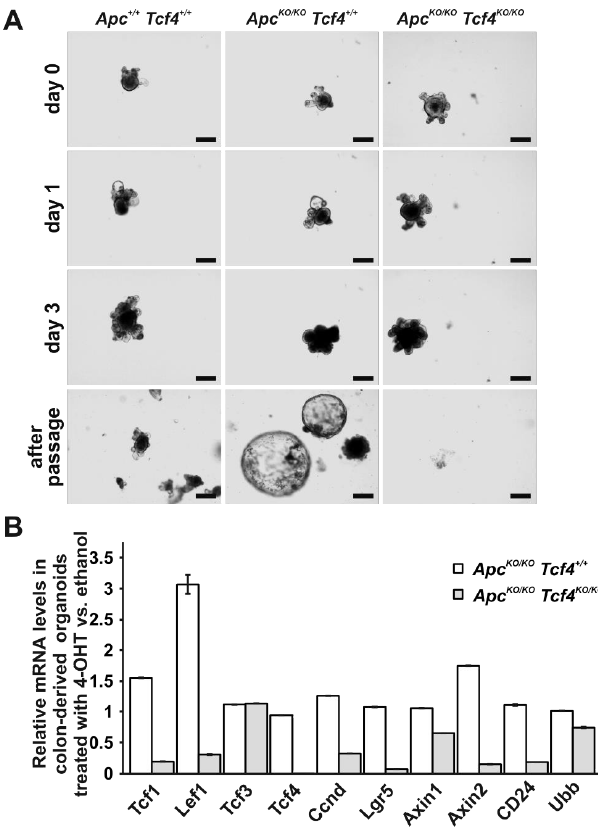
Figure 7. Demise of Apc/Tcf4 double-deficient colonic organoids. ( A ) Stereomicroscopic images of organoids derived from the colon of Apc +/+ Tcf4 +/+ Lgr5-CreERT2 ( Apc +/+ Tcf4 +/+ ), Apc flox14/flox14 Tcf4 +/+ Lgr5-CreERT2 ( Tcf4 +/+ Apc KO/KO ), and Apc flox14/flox14 Tcf4 flox5/flox5 Lgr5-CreERT2 ( Apc KO/KO Tcf4 KO/KO ) mice. The images were taken prior to (day 0), one and four days after 4-OHT treatment. The images at the bottom show organoids one day after splitting. Scale bar: 200 µ m; ( B ) qRT-PCR analysis of organoids derived from the indicated mouse strains. Total RNA was isolated from four (parallel) organoid cultures 48 h after 4-OHT or ethanol addition to culture media. Diagrams show the relative expression levels of the indicated genes in ethanol-treated organoids when compared to 4-OHT-treated organoids of the corresponding genotype. RNA levels were normalized to the Actb mRNA levels; Ubb represents an additional housekeeping gene. Error bars indicate